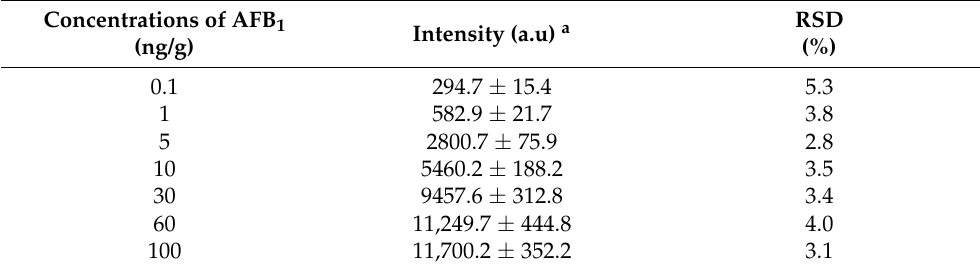
Table 3. Stability results of the different concentrations of AFB 1 using Apt-strip ( n = 5).